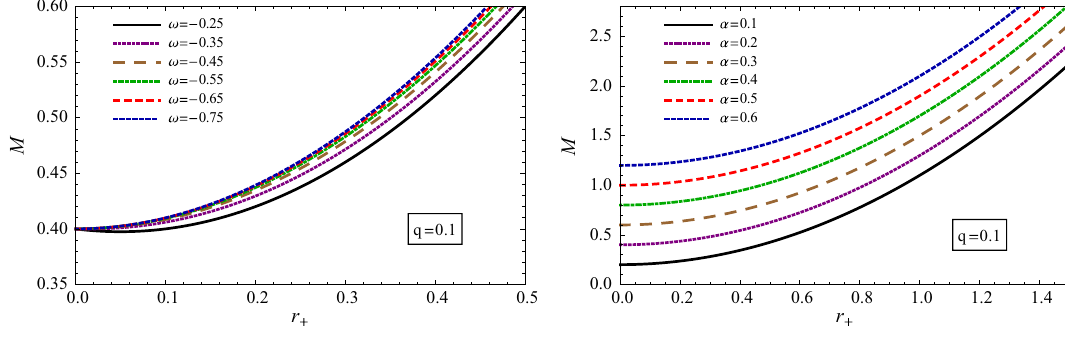
Fig. 2 Plot showing the behavior of mass M EGB + vs. horizon radius r + for 5D Einstein–Gauss–Bonnet black hole surrounded by the quintessence